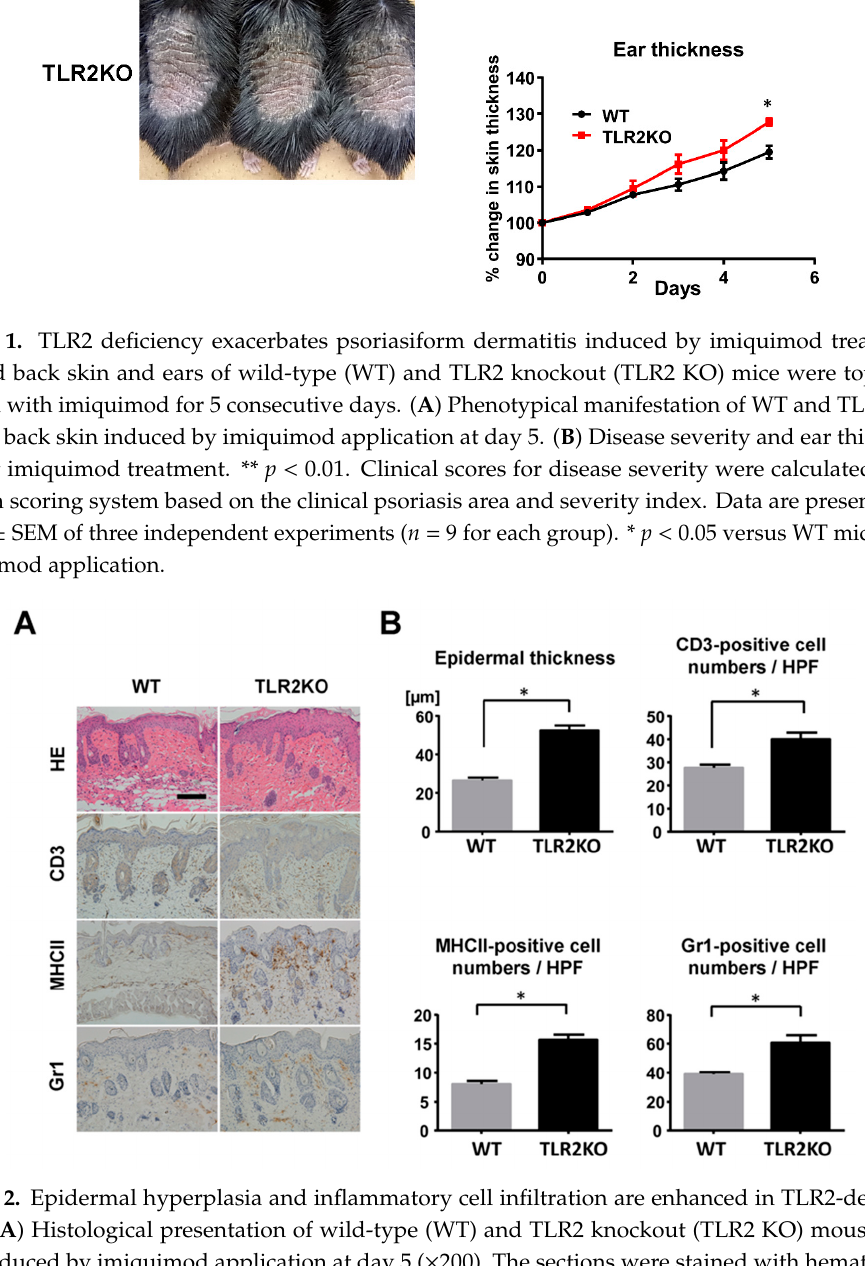
Figure 2. Epidermal hyperplasia and inflammatory cell infiltration are enhanced in TLR2-deficient mice. ( A ) Histological presentation of wild-type (WT) and TLR2 knockout (TLR2 KO) mouse back skin induced by imiquimod application at day 5 ( × 200). The sections were stained with hematoxylin and eosin (HE) or immunostained for CD3, major histocompatibility complex (MHC) class II (MHCII), or Gr1. Representative pictures from 9 mice per group. Scale bar, 50 mm. ( B ) The number of epidermal cell layers and dermal inflammatory cells were counted per high-power field. Data are presented as mean ± SEM of three independent experiments ( n = 9; * p < 0.05).